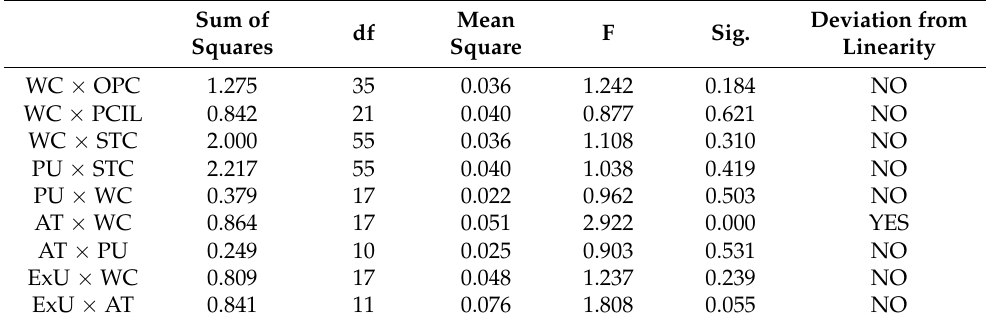
Table 9. ANOVA Test of Linearity. Sum